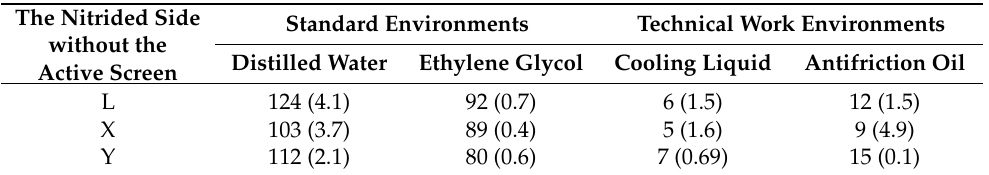
Table 6. The values of the contact angles on different angular surfaces and error bars in the brackets for samples nitrided in plasma without an active screen. The Nitrided Side without the Active Screen